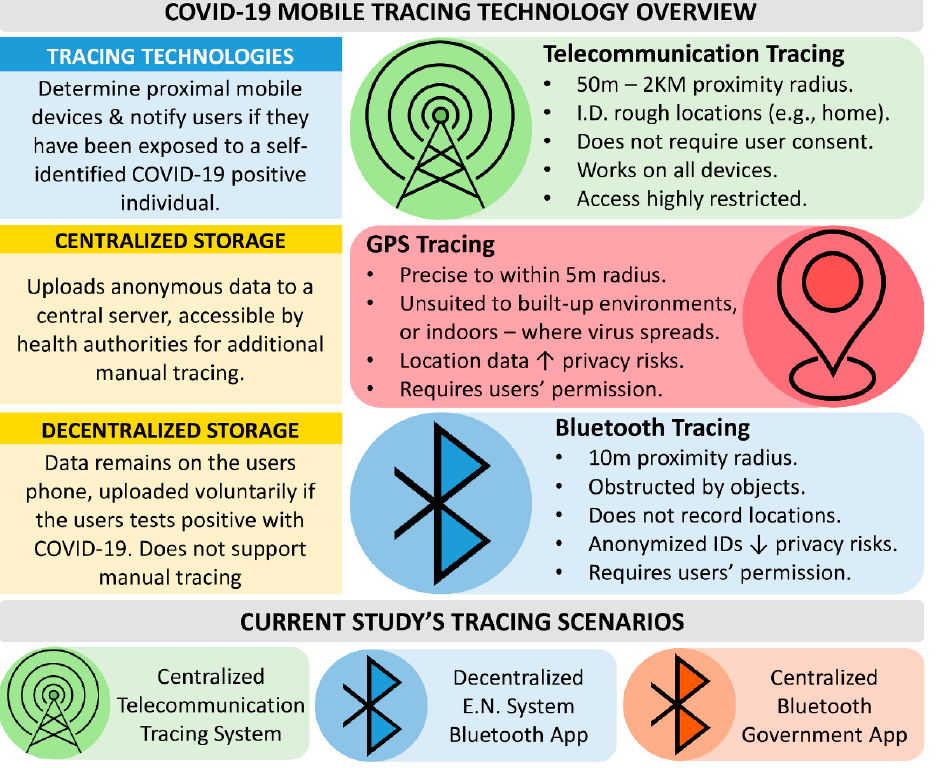
Figure 1. COVID-19 mobile tracing technologies, storage options, and the three tracing scenarios surveyed in the current study. A detailed description of each tracing scenario is presented in the supplementary materials.